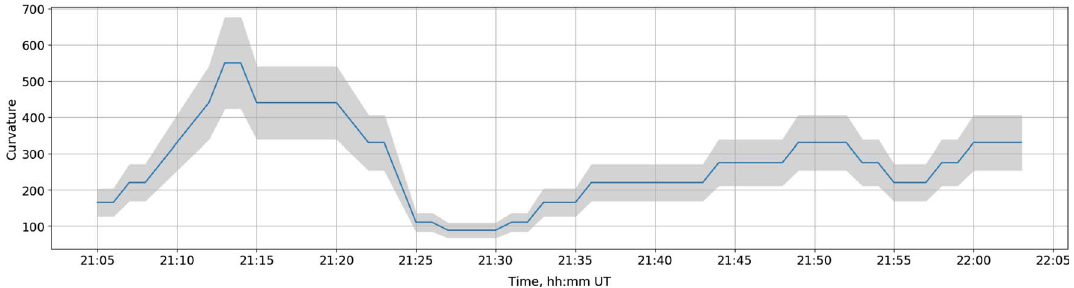
Fig. 4. Curvatures of the steeper arc seen in delay-Doppler spectra calculated using data from CS103, from simple parabolas fi tted by eye. The grey bounds represent an estimated error.